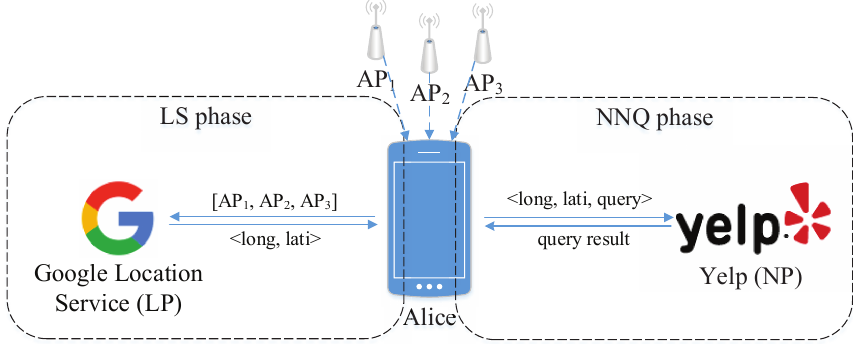
Figure 1. An example of LS and